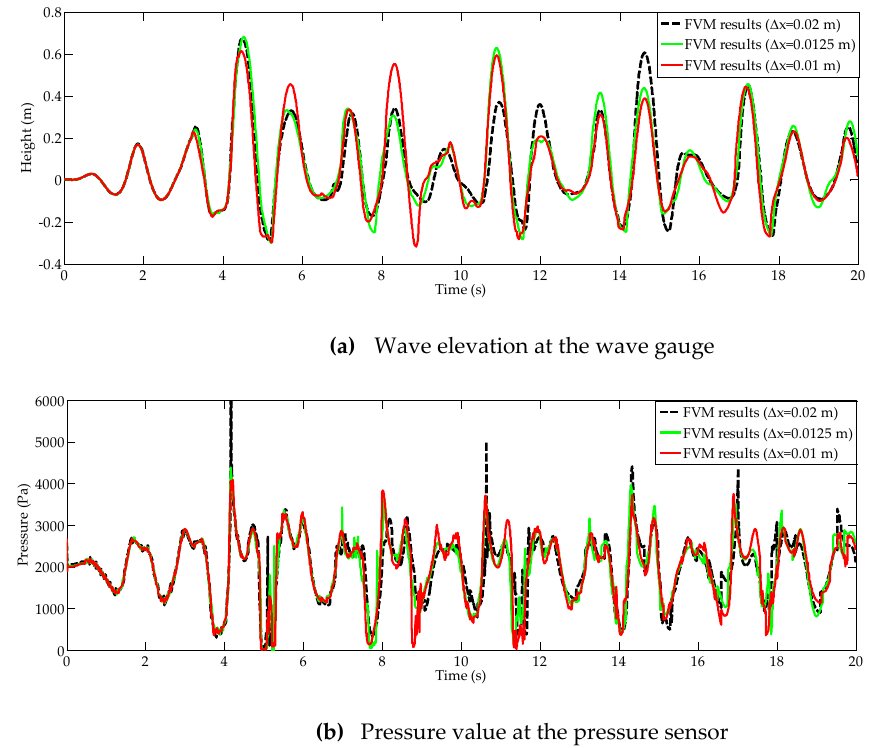
Figure 15. Numerical results obtained by FVM simulations: ( a ) Wave elevation at the wave gauge; ( b ) Pressure value at the pressure sensor.